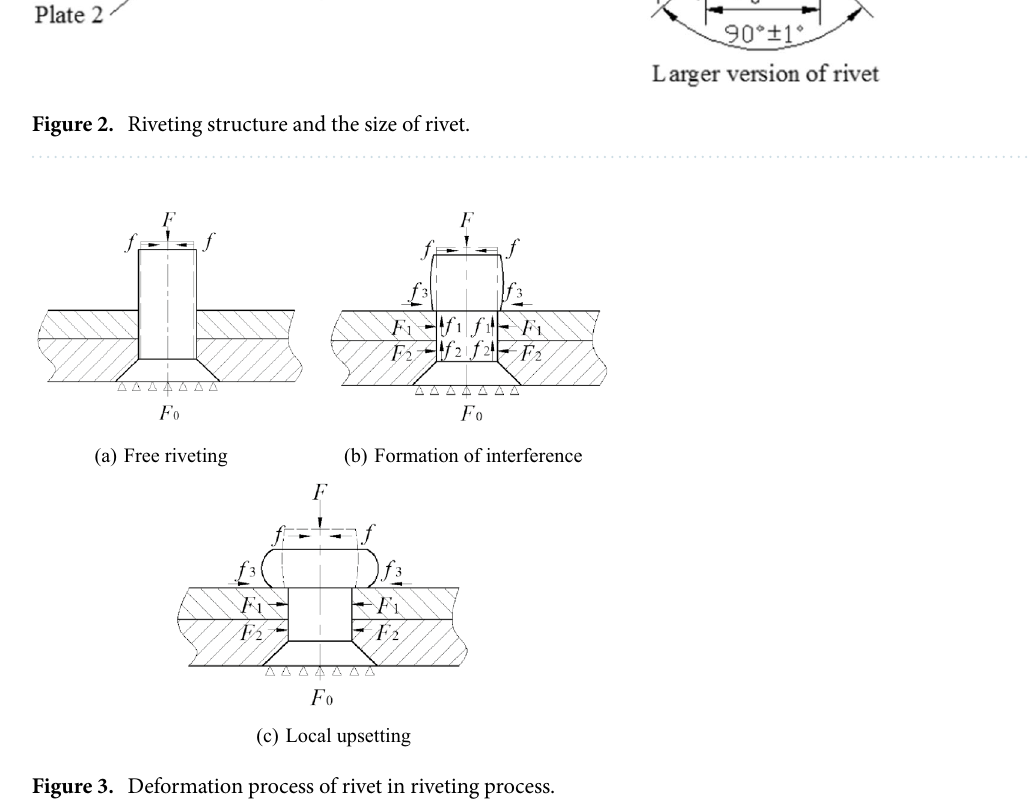
Figure 3. Deformation process of rivet in riveting